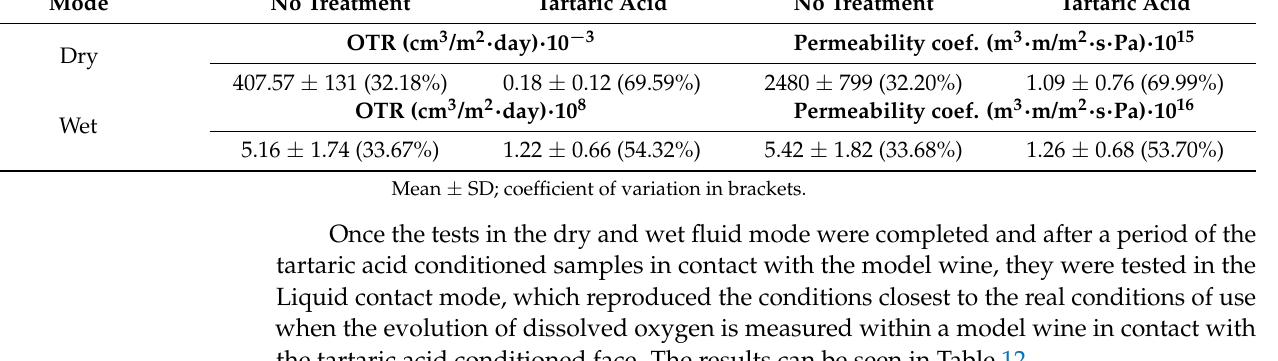
Table 11. Main permeation results of tested C-DVTec pieces in Fluid mode, dry and wet, ( n = 7). Mode